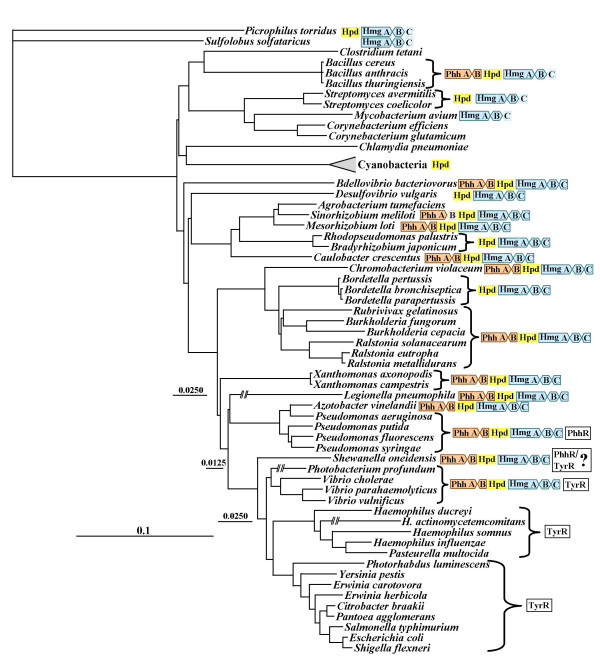
Distribution of modules of aromatic catabolism mapped on a 16S rRNA tree. In this figure, only presence or absence (not gene order) is indicated. The Phh module (orange) consists of phenylalanine hydroxylase (PhhA), carbinolamine dehydratase (PhhB), and tyrosine aminotransferase (not shown, see Text), and accomplishes the overall conversion of PHE to 4-hydroxyphenylpyruvate. The Hpd module (yellow) is 4-hydroxyphenylpyruvate dioxygenase, which converts 4-hydroxyphenylpyruvate to homogentisate. The Hmg module (blue) catalyzes the 3-step conversion of homogentisate to acetoacetate and fumarate. The distribution of PhhR and TyrR is shown in boxes. In some cases the HmgC member is shaded light blue to indicate that the gene encoding this isomerase could not be found and is probably encoded by an as yet unknown analog. Some long branches are drawn with gaps that represent 25% of the length of the scale bar.